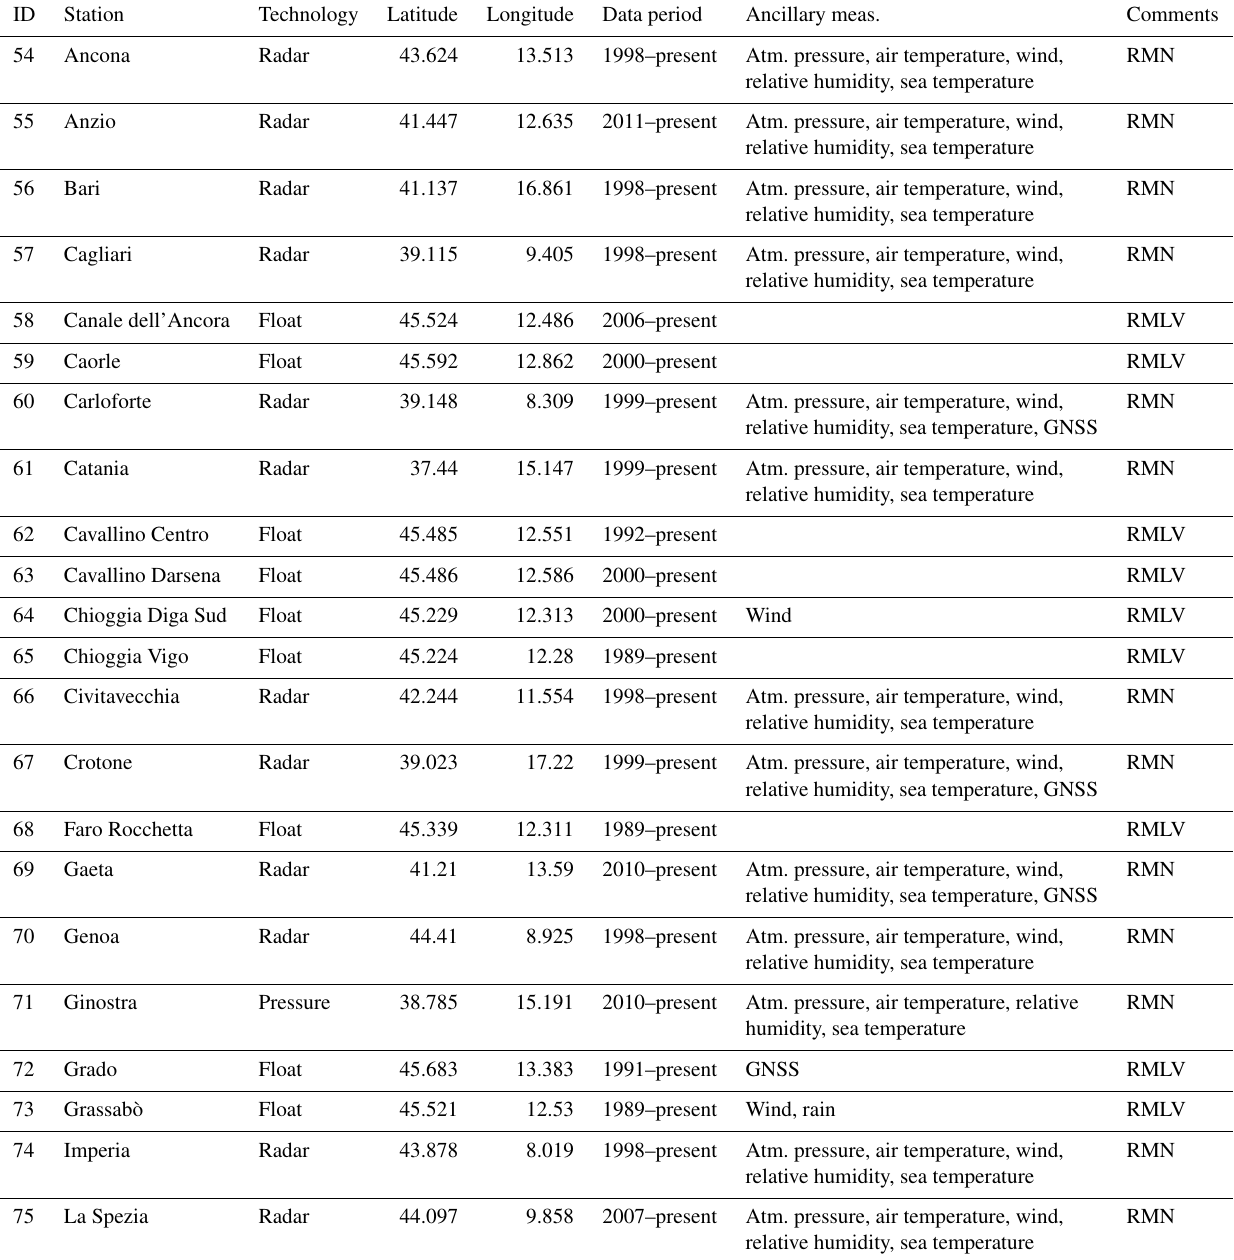
Table A8. Stations operated by ISPRA – Italian Institute for Environmental Protection and Research (RMN – national tide gauge network; RMLV – Venice Lagoon and North Adriatic Tide Gauge